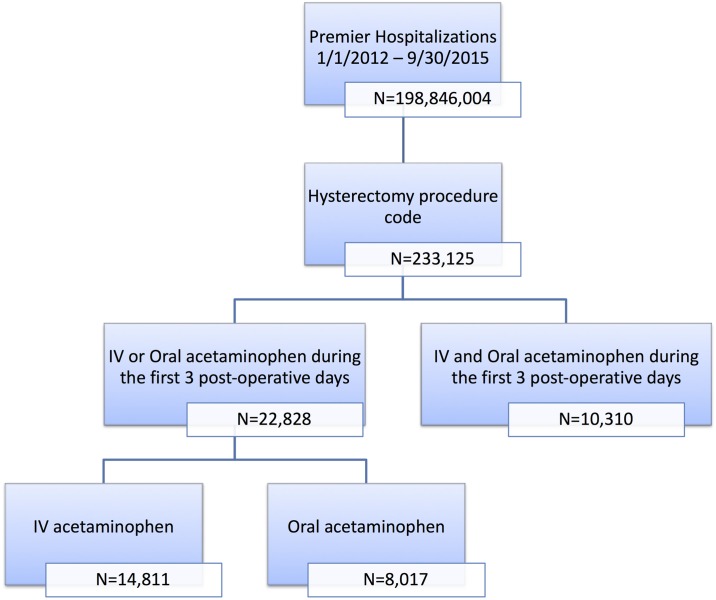
Sample selection.